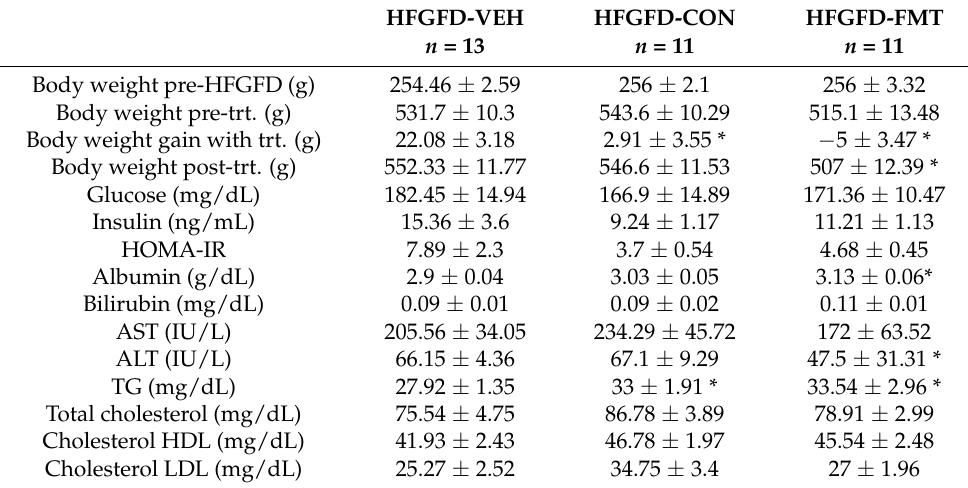
Table 1. Biochemical characteristics after 2 weeks of intervention in the rat NASH model of PHT. HFGFD-VEH: group of NASH rats receiving sham gavage (vehicle); HFGFD-CON: group of NASH rats receiving the 9-strain bacterial consortium daily; HFGFD-FMT: group of NASH rats receiving fecal microbiota transplantation from control lean rats (1 × transplantation followed by sham gavage). HFGFD-VEH HFGFD-CON n = 13 Body weight pre-HFGFD (g)